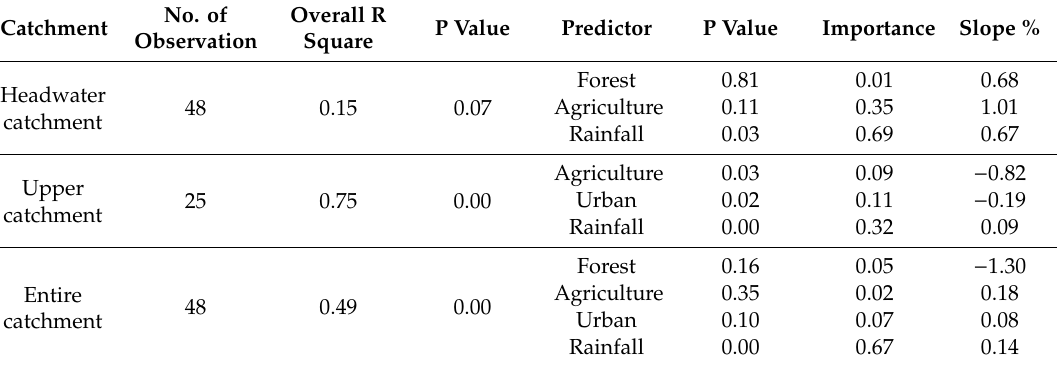
Table 7. Multiple regression results showing contributions of rainfall and major LULC changes on river